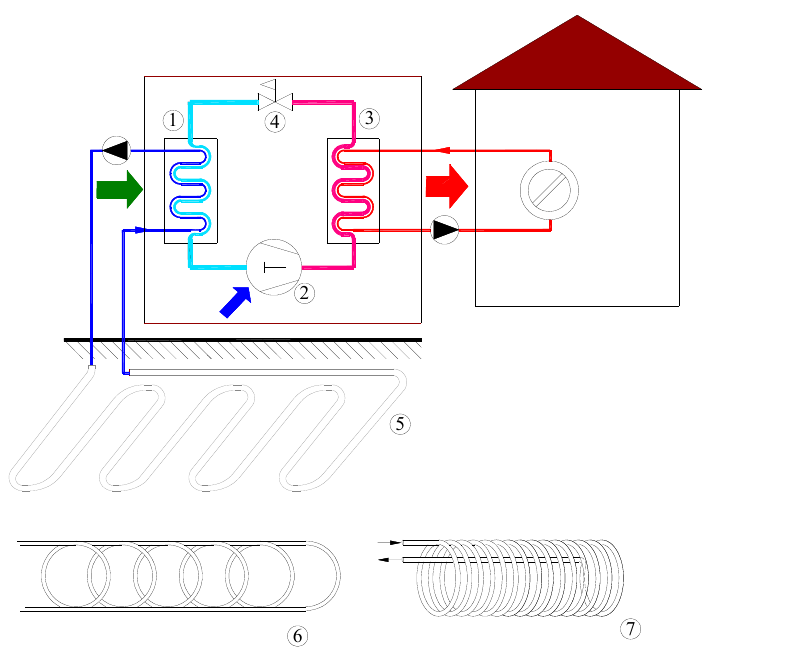
Figure 2. Horizontal heat exchanger coupled to the heat pump (1—evaporator, 2—compressor, 3—condenser, 4—expansion valve, 5—linear loop, 6—slinky coil, 7—spiral coil).